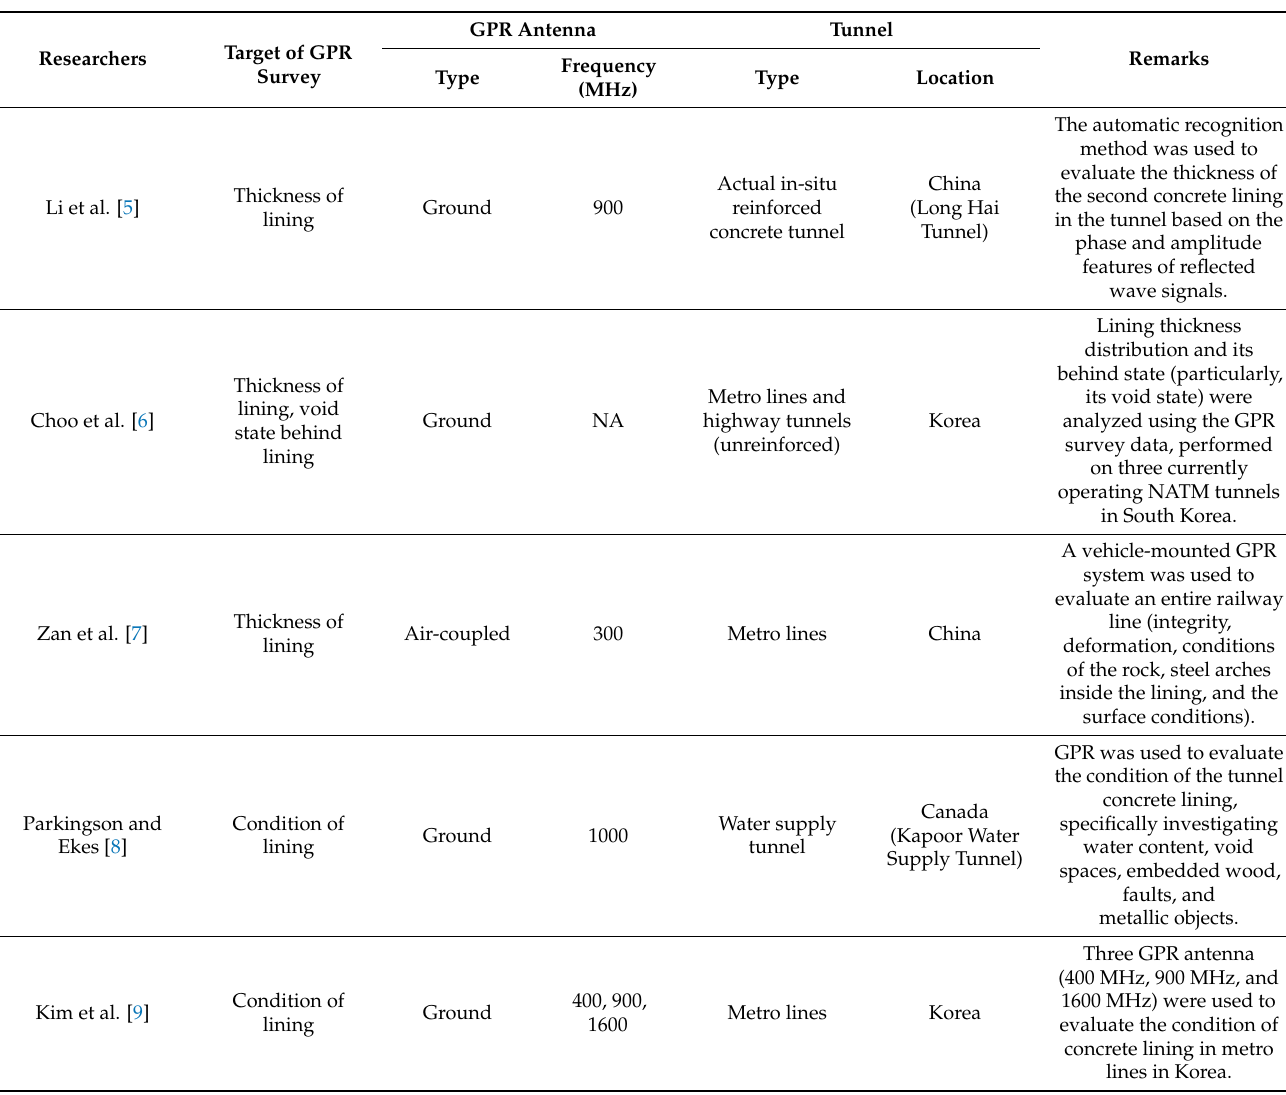
Table 1. Summary of GPR survey for evaluation of lining concrete in